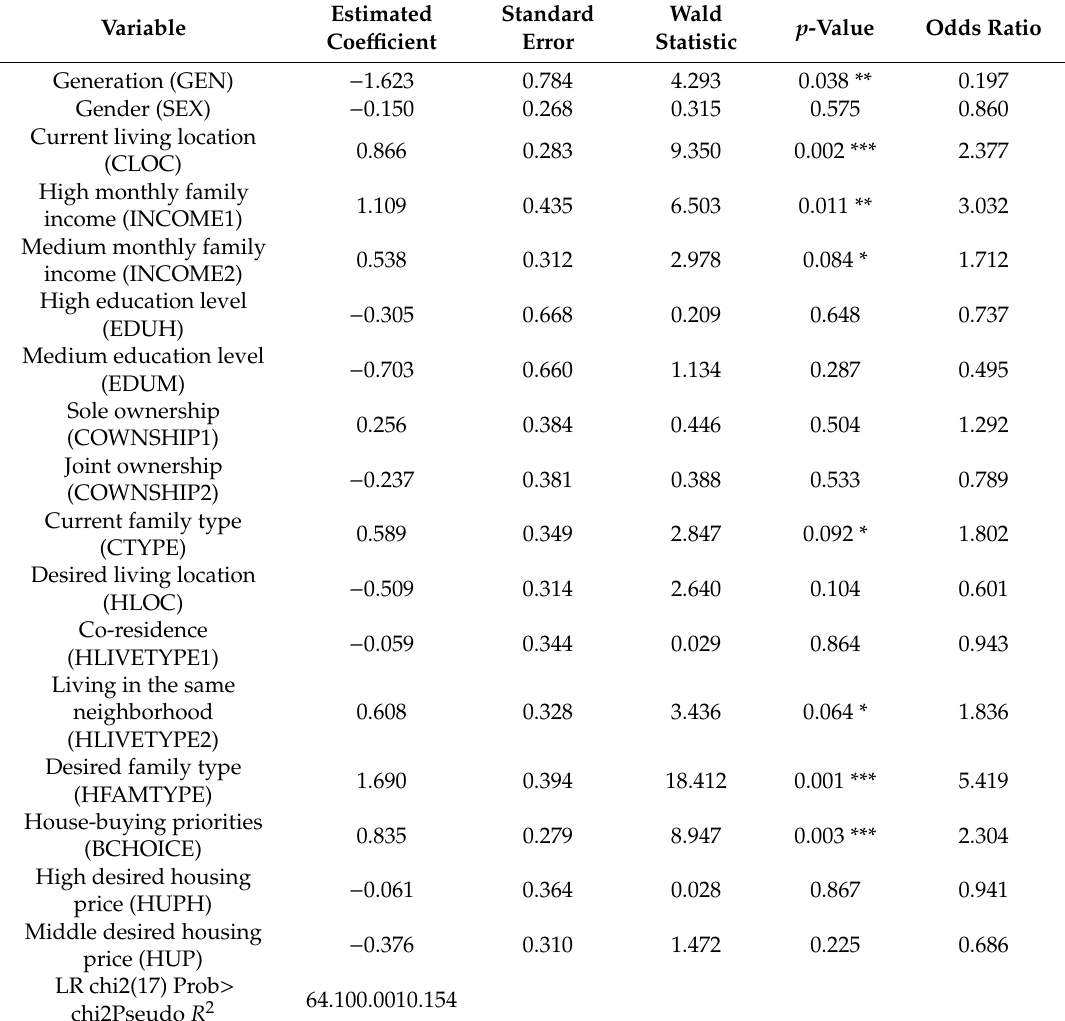
Table 3. Statistical estimation results ( n =